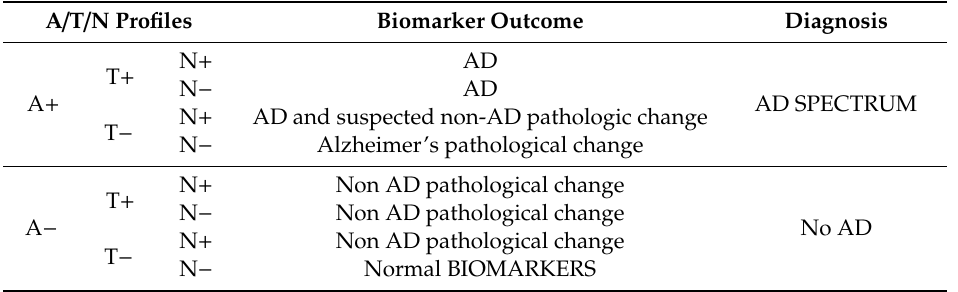
Table 2. Outcomes on the biomarker’s A / T / N classification [113]. A: amyloid. N: Neurodegeneration. T: